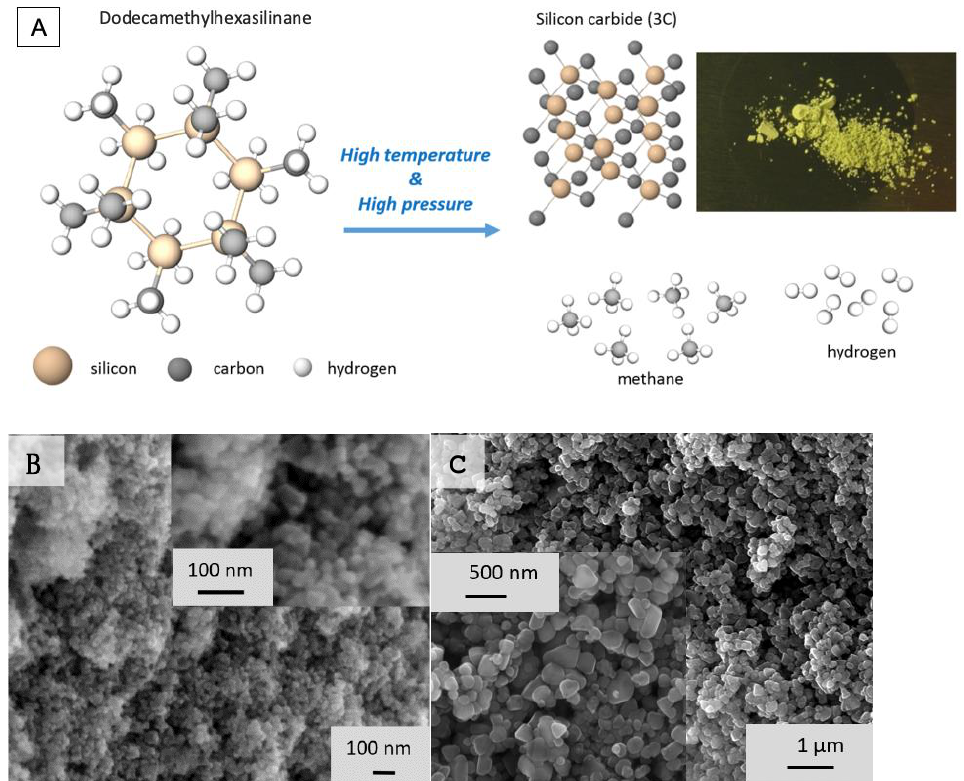
Figure 1. ( A ) The structure of dodecamethylhexasilinane (C 12 H 36 Si 6 ) molecule and scheme of SiC formation in HTHP reaction. Photos in the right part of ( A ) show an example of 3C SiC powders obtained at 2000 °C. ( B , C ) SEM images of 3C SiC powders synthesized at temperatures of 1250 °C and 1400 °C, respectively.